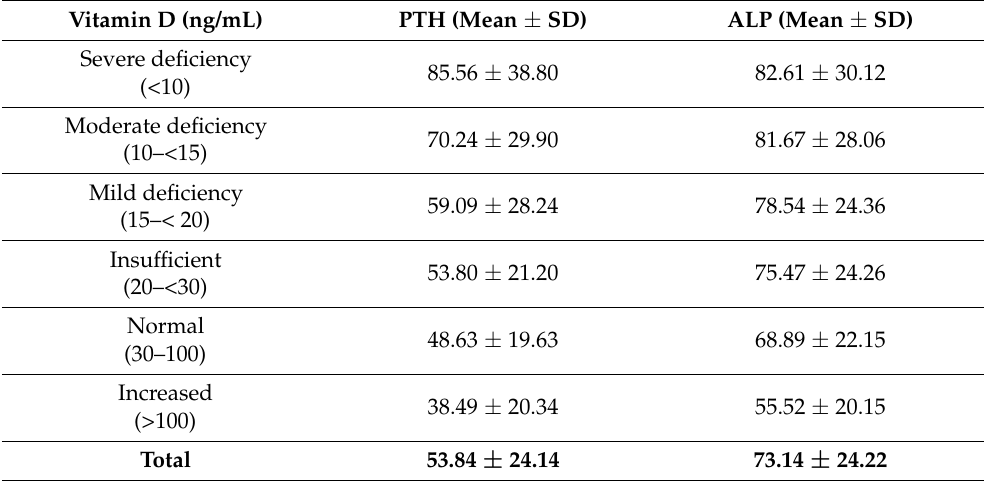
Table 4. Mean and SD of PTH and ALP according to vitamin D interval (classification).